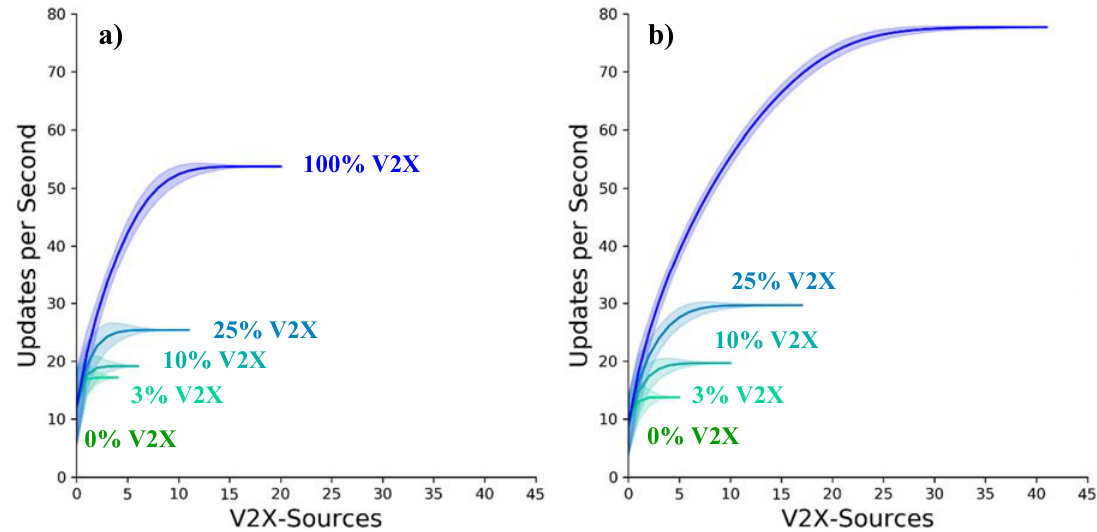
Figure 11. Updates per second for ( a ) the low-density scenario and ( b ) the high-density scenario, displaying the contribution of each connected station in dependence of the V2X equipment rate.